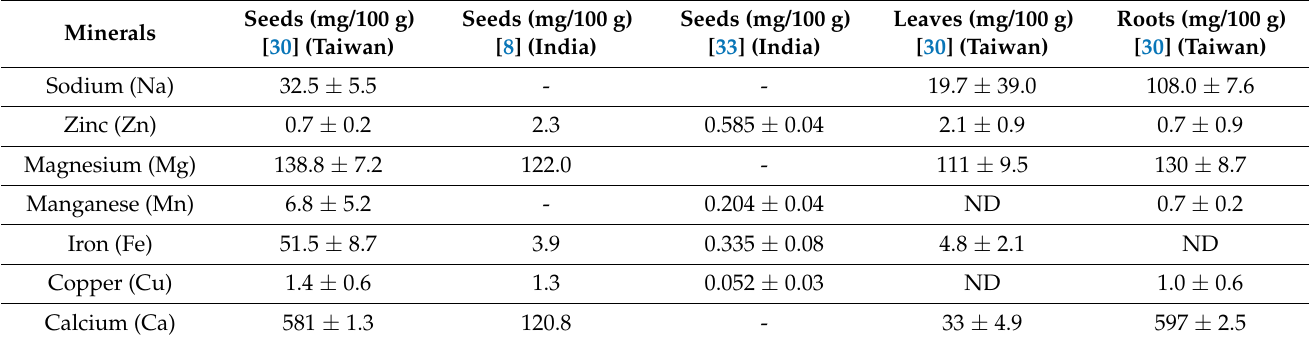
Table 5. Mineral composition of Cajanus cajan